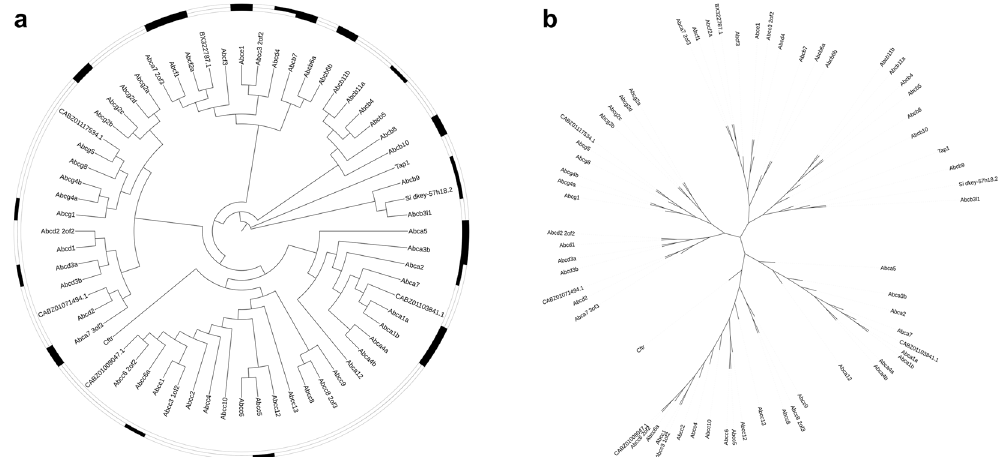
Figure 6. Zebrafish neutrophils and non-neutrophil cells express distinct subsets of ABC transporter proteins. Scalable phylogenetic trees in both ( a ) circular and ( b ) unrooted display modes indicate evolutionary relationships between ABC transporter proteins in zebrafish (branch lengths are not proportional to genetic distance; see Supplementary Fig. S6 for trees with proportional branch lengths). In ( a ), for both neutrophil (inner circle) and background cell (outer circle) expression data, expressed proteins are marked with a black box, whereas proteins not expressed are